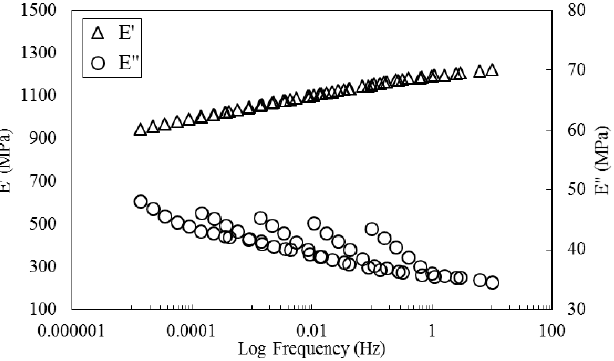
Figure 7. Master curves generated by solely horizontal shifting of storage modulus curve and using the same shift factors for loss modulus curves.